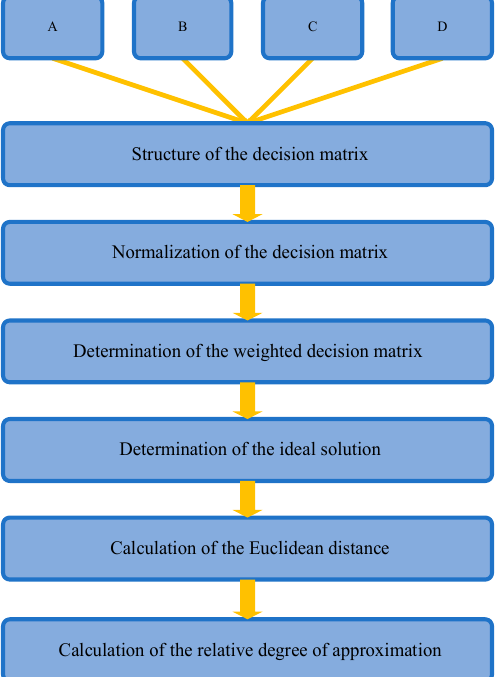
Figure 3. The TOPSIS feature ranking process integrates di ff erent FFS methods ranking.